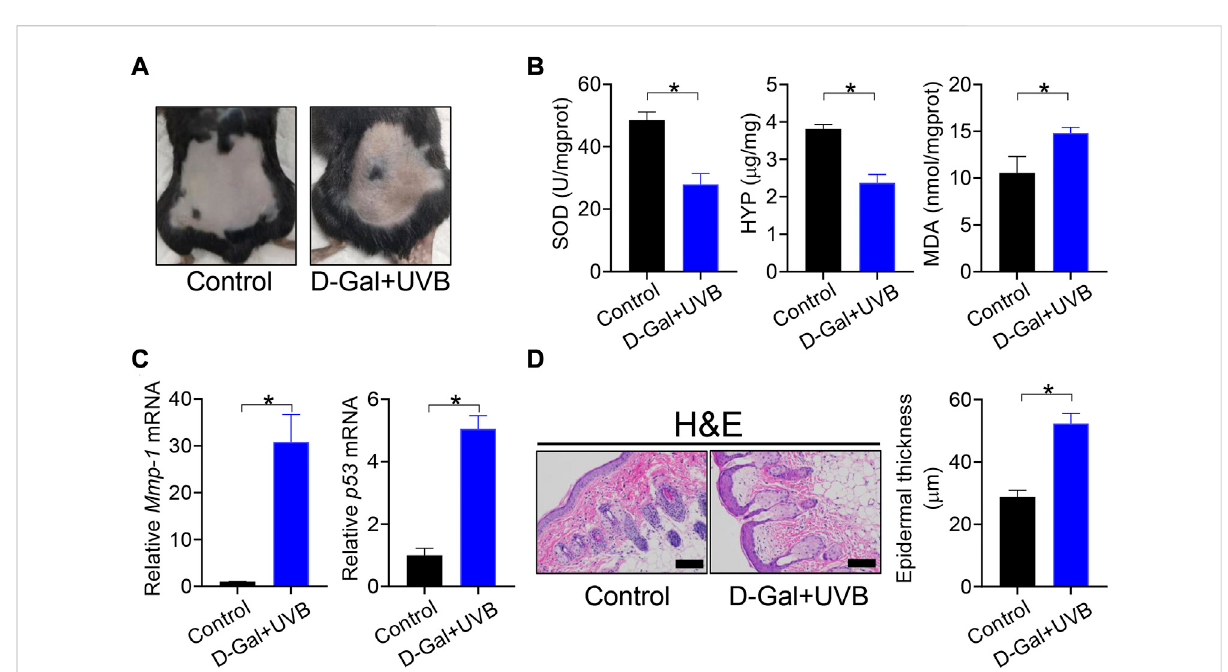
FIGURE 1 Establishment of mice with skin aging . (A) Surface examination of dorsal skin derived from D-gal/UVB-treated and control mice. (B) Skin SOD activity and HYP/MDA levels in D-gal/UVB-treated and control mice. Data are mean ± SD ( n = 7). * p < 0.05 ( t -test). (C) mRNA expression of Mmp-1 and p53 in the skin of D-gal/UVB-treated and control mice. Data are mean ± SD ( n = 7). * p < 0.05 ( t -test). (D) H&E staining (left panel) and epidermal thickness (right panel) of skin derived from D-gal/UVB-treated and control mice. Scale bar = 100 μ